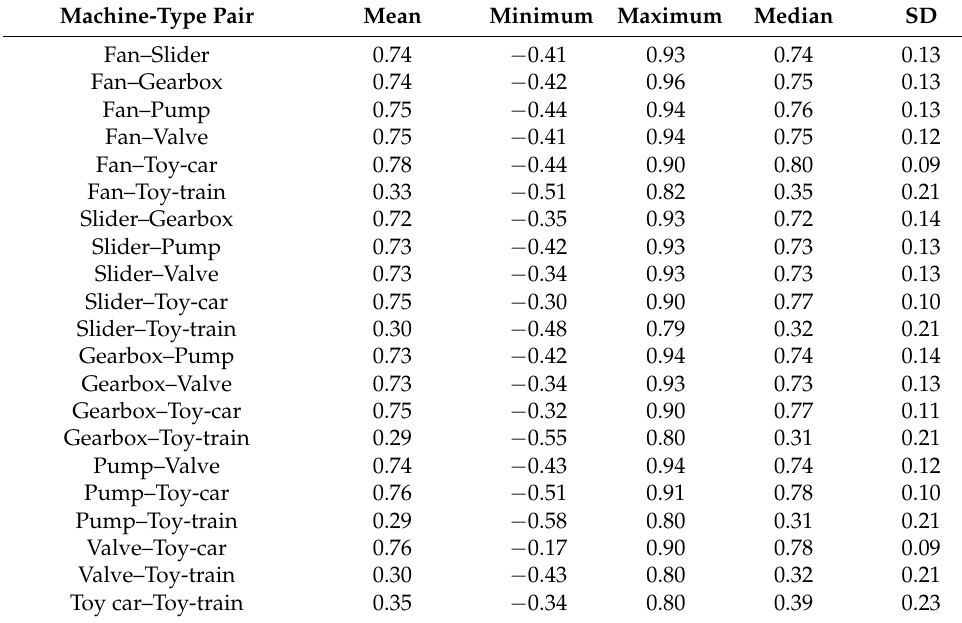
Table 2. Statistical quantities of interclass similarity obtained using PCC measure calculated from the full dataset.